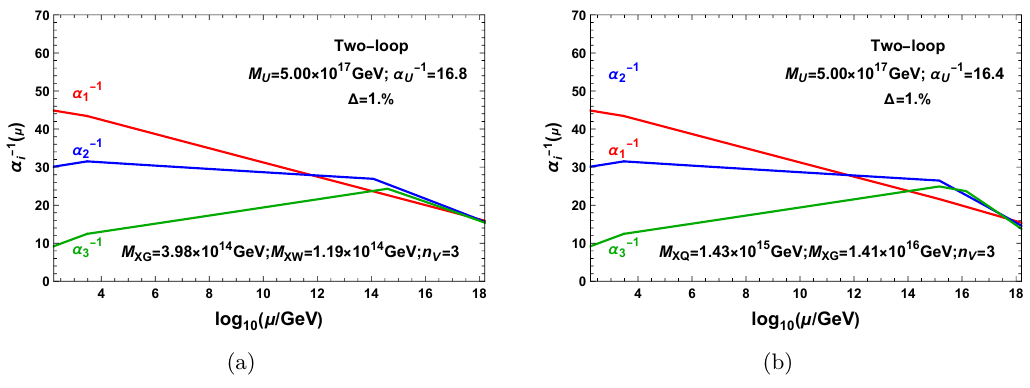
Figure 12 . Two-loop evolution of gauge couplings for the Model 7 with vector-like particles. In the model, k = 25 × 5 and k = 1 . The string-scale gauge coupling relations can be achieved by Y 2 19 3 adding 3( XG + XW ) (a) and 3( XQ + XQ ) + 3 XG